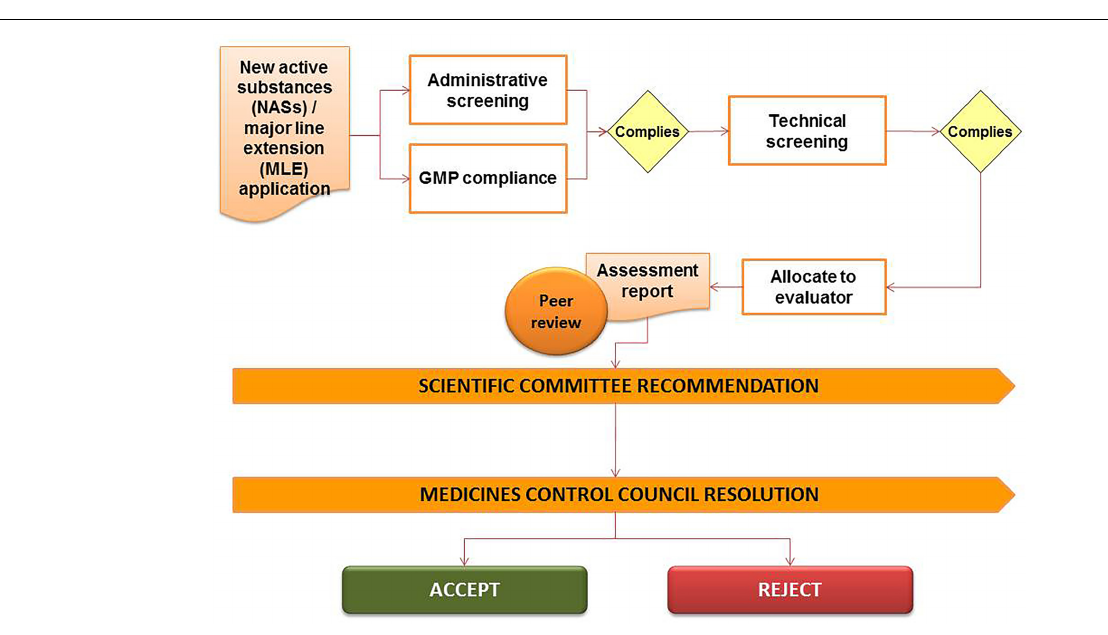
FIGURE 2 | Regulatory review process of the Medicines Control